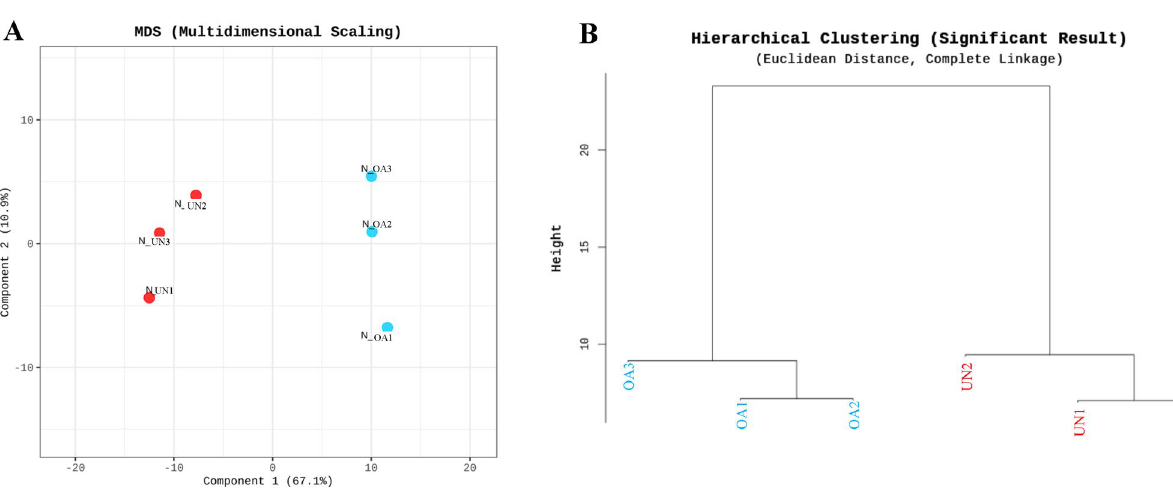
Figure 2. The results of multi-dimensional scaling and hierarchical clustering. Using each sample’s normalized value, the similarity between samples was graphically shown in a 2D plot to show the variability of the total data ( A ), and the high expression similarities were grouped ( B ) (Distance metric = Euclidean distance, Linkage method = Complete linkage). The composition of miRNAs in samples from the OA and unaffected groups was similar in each group. UN, unaffected group; OA, osteoarthritis